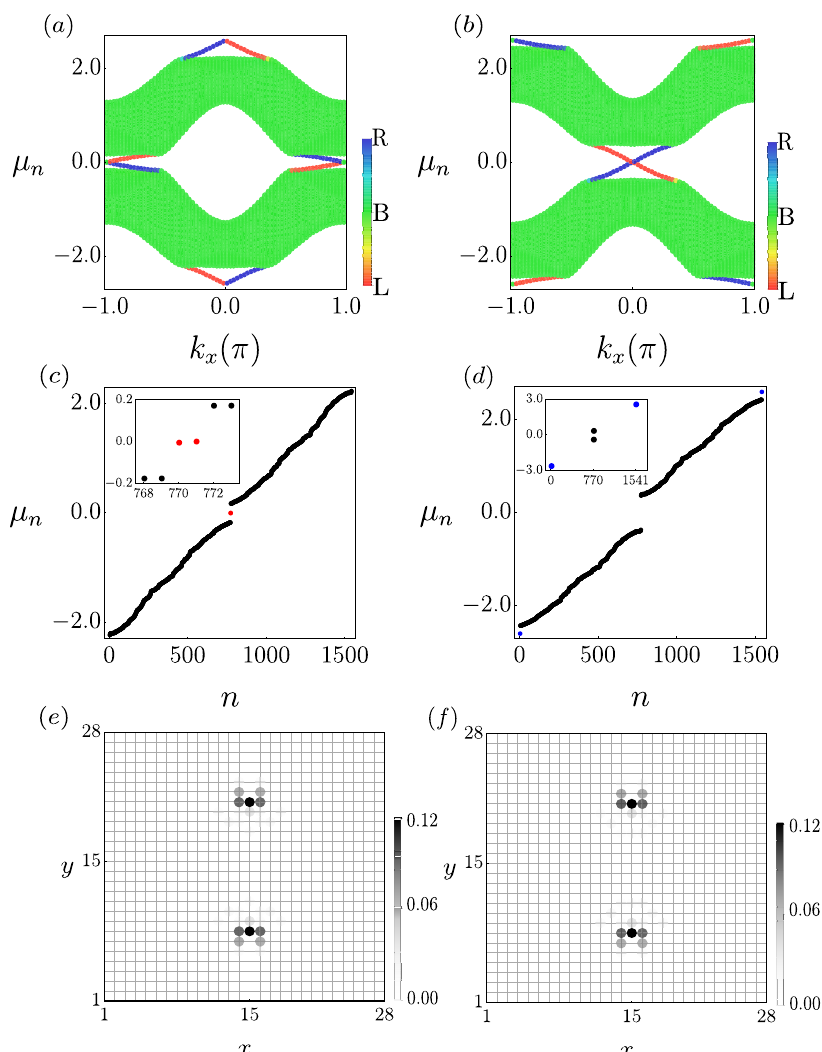
Fig. 4 Translationally active Floquet topological insulators (FTIs) in the intermediate frequency regime. Edge modes of FTIs with a Chern number C = 2 for drive amplitude m 1 = − 5.17 and drive frequency ω = 5.2, and (b) C = − 2 for m 1 = − 8.32 and ω = 5.2, in a semi-in fi nite system. The Floquet-Bloch band inversion occurs at k x = π (0) at a Floquet zone center (boundary) and b Floquet zone boundary (center). Respectively, these two phases support c normal (red) and d anomalous (blue) modes in a periodic system with a dislocation-antidislocation pair with Burgers vectors b = ± a e x . The local density of states for e normal and f anomalous dislocations